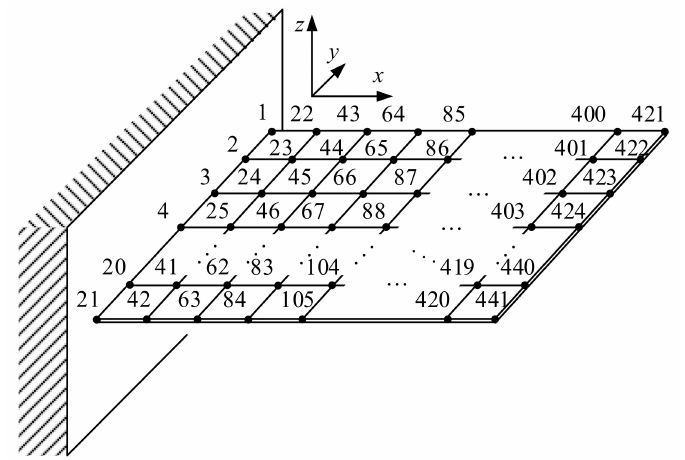
Figure 7. Schematic diagram of the cantilever plate finite element